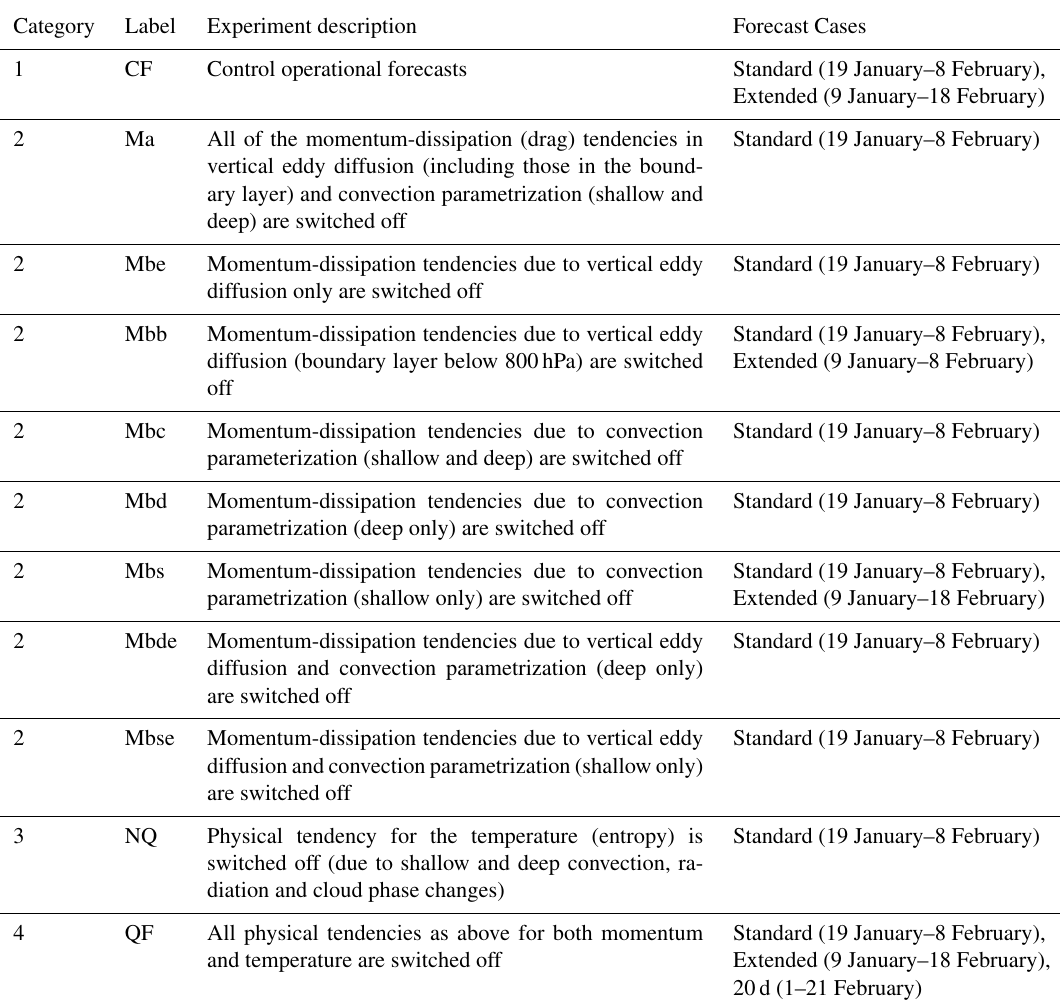
Table 2. List of sensitivity experiments at TCo639 with 137 vertical levels. The columns show the categories according to Table 1, the label used in the text, the experiment description and the forecast cases (standard and extended).